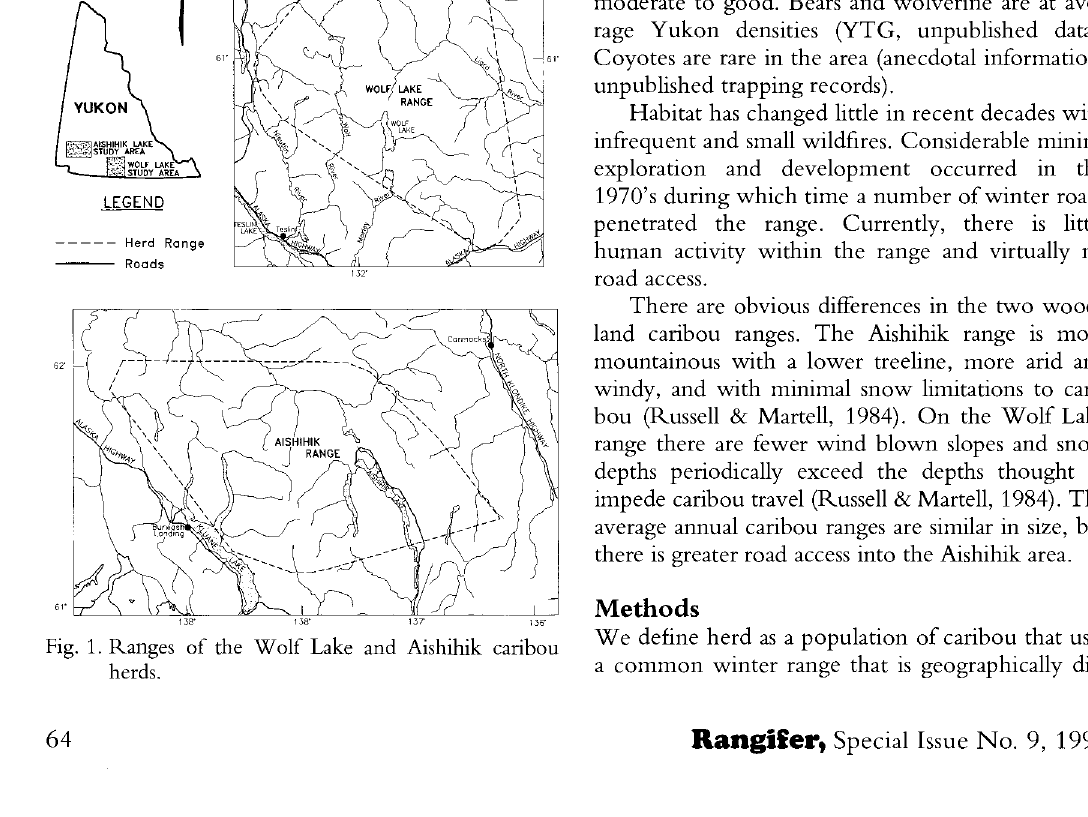
Fig. 1. Ranges of the Wolf Lake and Aishihik